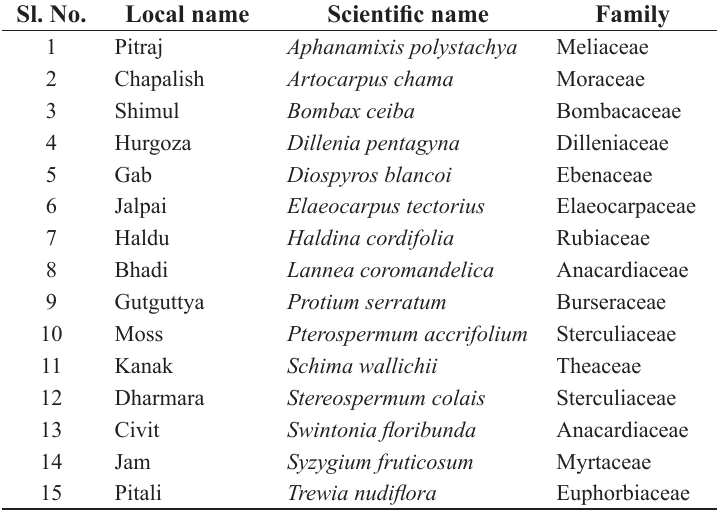
Table 3: Regenerating tree species in Rampahar Forest Reserve.